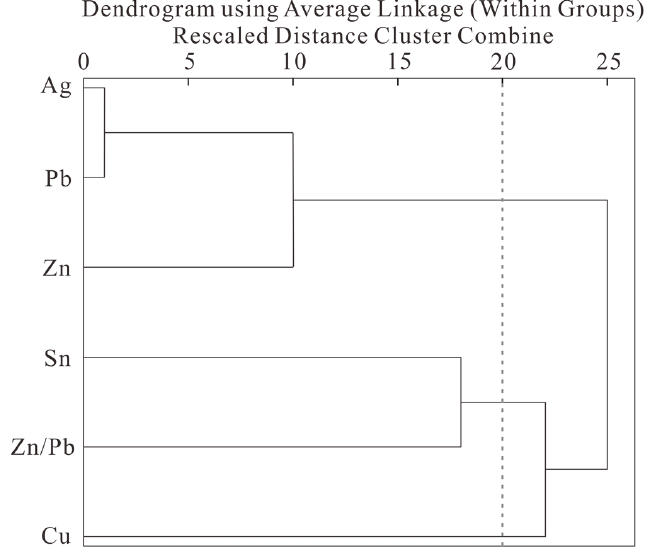
Figure 6. R-type cluster analysis results for the ore-forming elements.